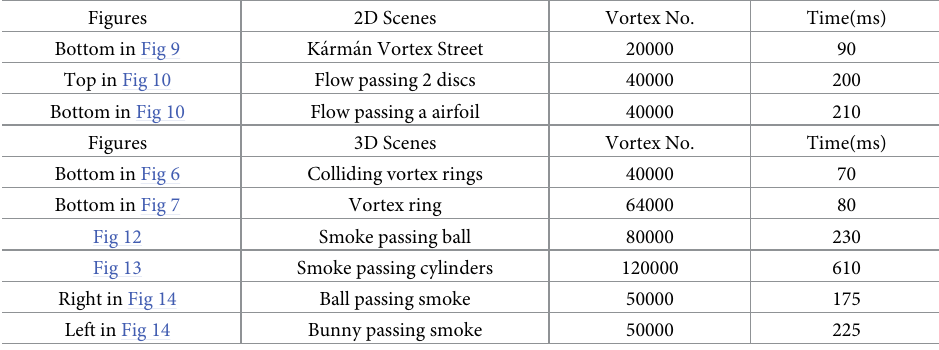
Table 1. Performance statistics of smoke